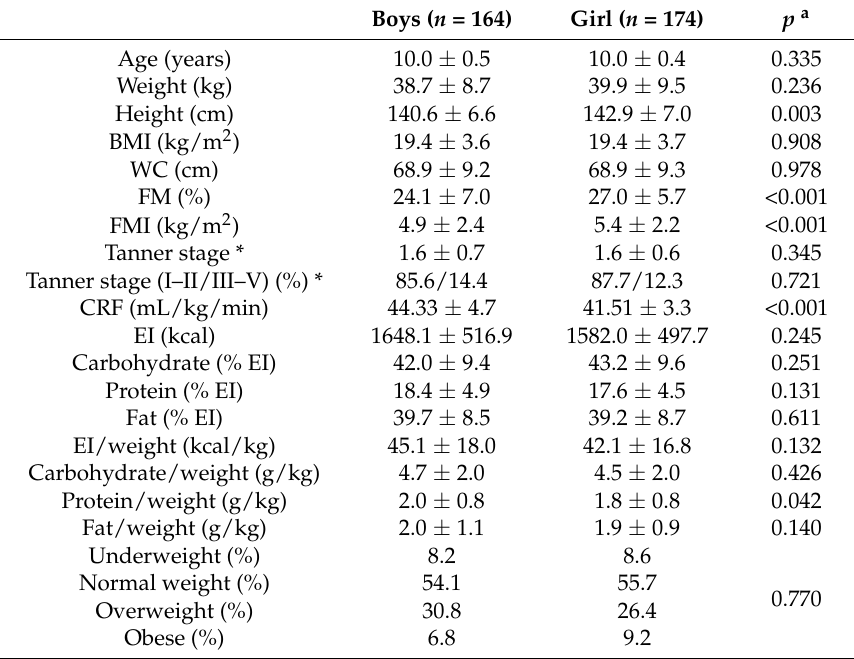
Table 1. Characteristics of the study